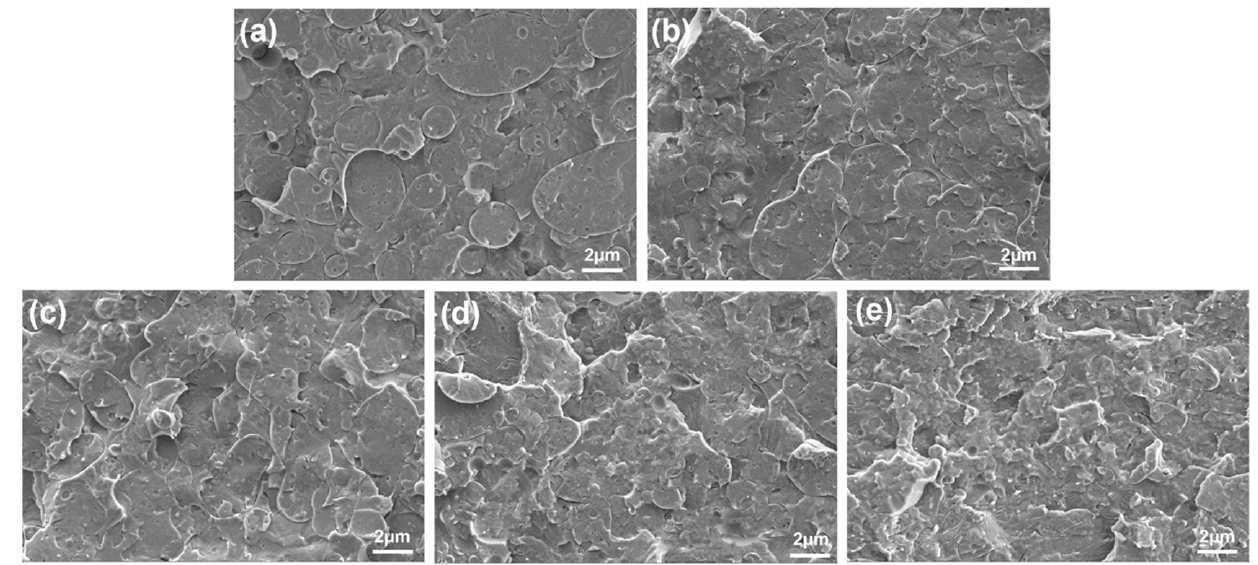
Figure 5. SEM images of the PLA/PCL nanocomposites: ( a ) PN4, ( b ) PN4-0.25, ( c ) PN4-0.5, ( d ) PN4-0.75, and ( e ) PN4-1.